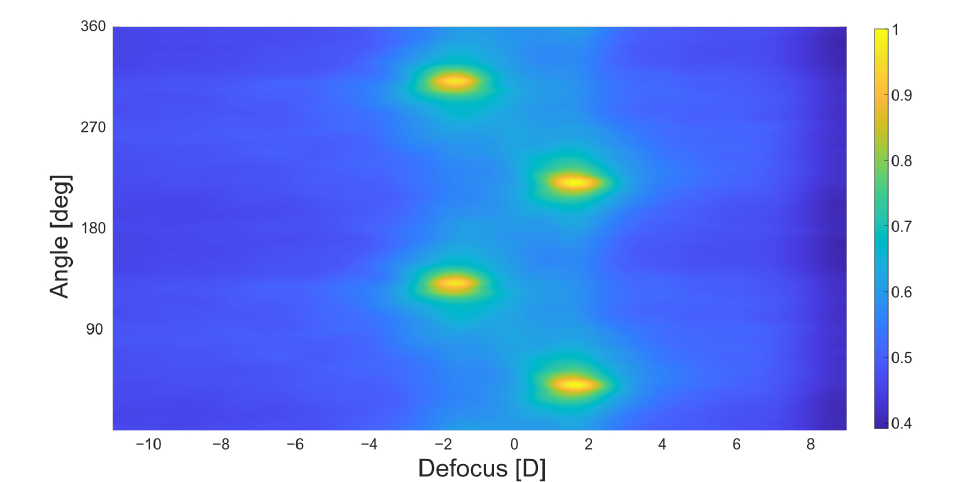
Figure 2. Example for the intensity matrix of an astigmatic